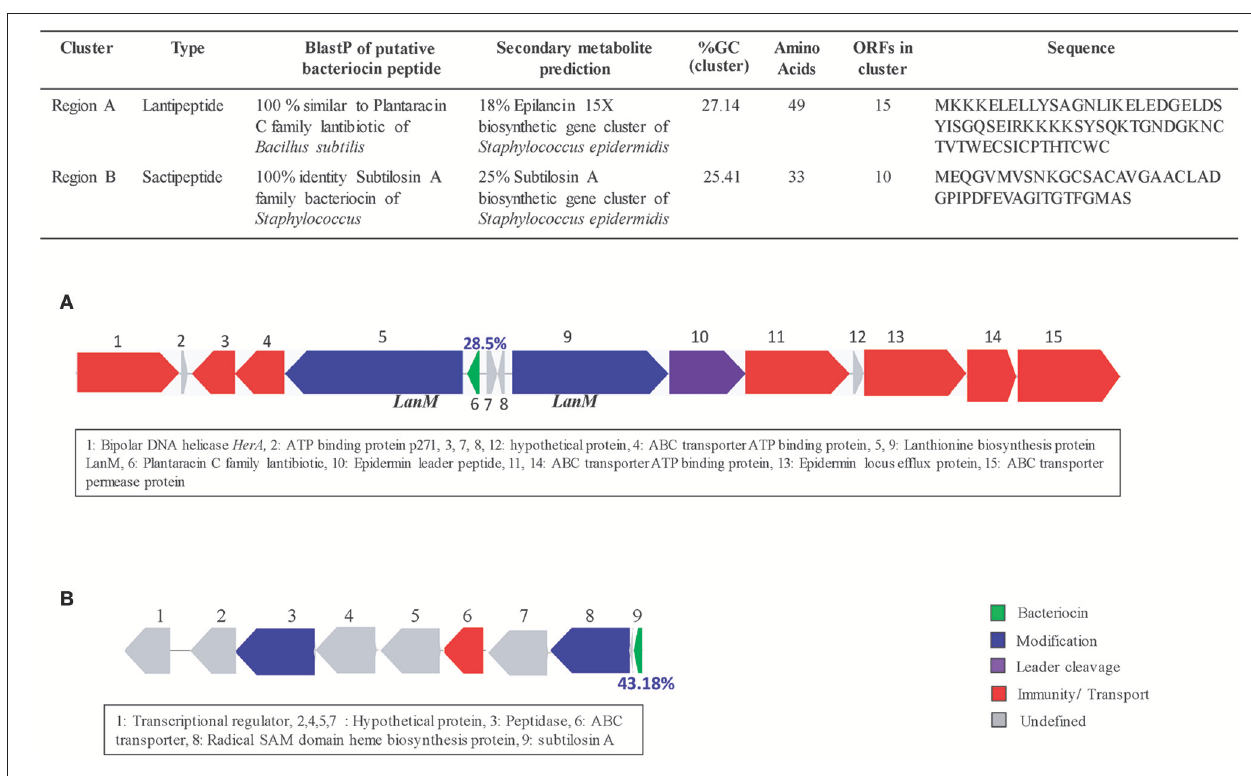
two different kinds of population will help in understanding the adaptation of these two different kinds of isolates and will throw light on the differentiating ability of these